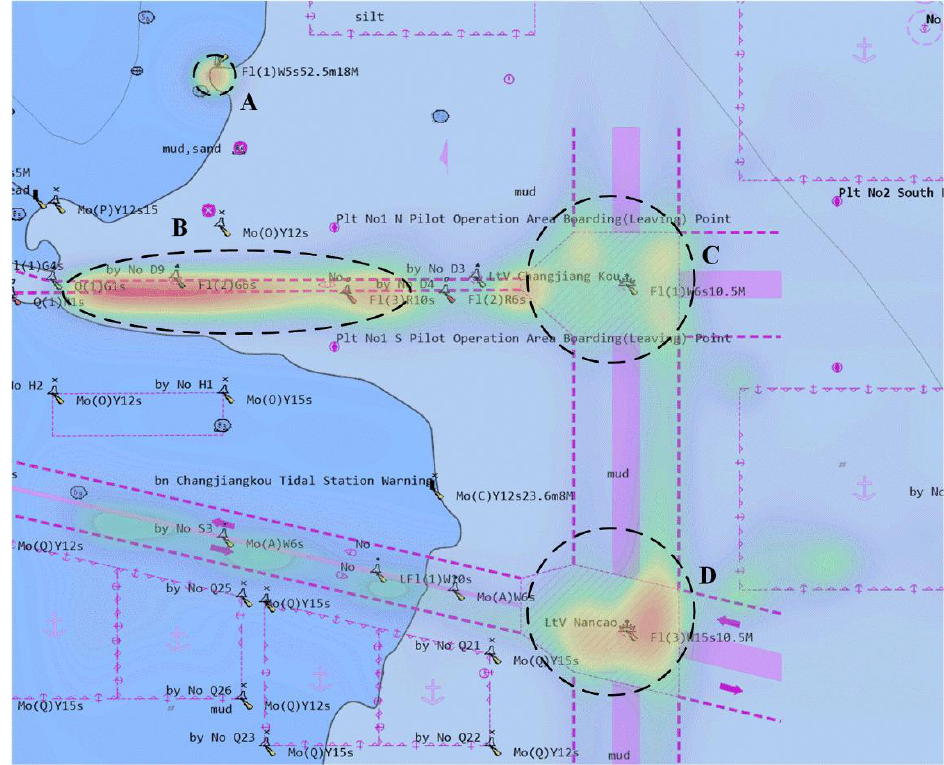
Figure 9. Heatmap of vessels in the Yangtze River Estuary at a certain time on 10 April 2019.